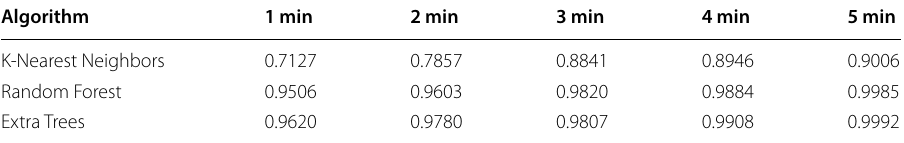
Table 3 Identification accuracy for knn, ransom forest and Extra Trees algorithms and dif- ferent training (Learning) times using the security dataset Algorithm 1